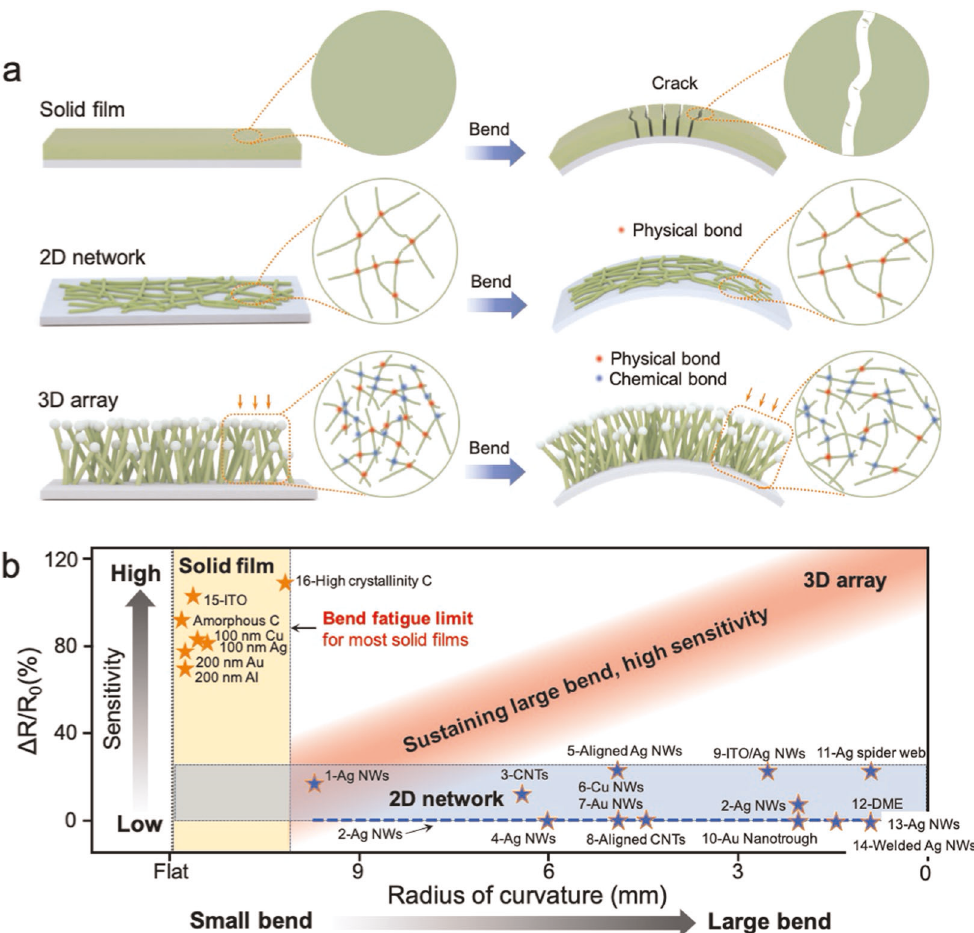
Fig. 1 Film-based fl exible electronics and their performance. a Schematic illustrations of solid fi lm, 2D networks, and 3D array-based fi lms under bend. b Summary of the sensitivity with bend ratios from fi lm-based fl exible electronics. (References could be fi nd from the Supplementary